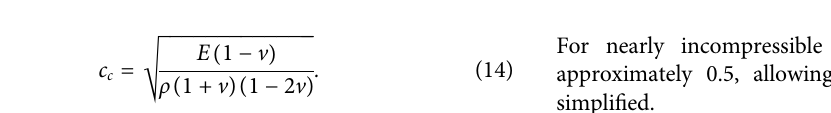
FIGURE 4 | Illustration of the creep and stress relaxation behaviors of the fractional rheological models with selective values of α